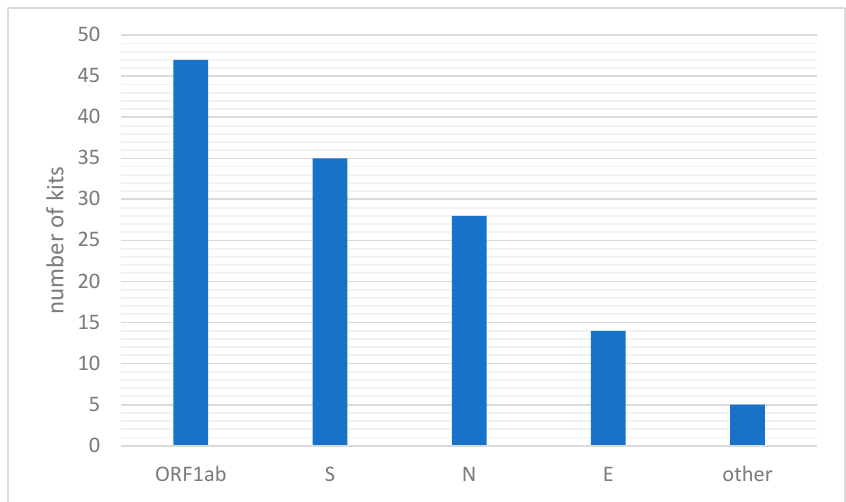
Figure 2. The number of genes detected by PCR tests for SARS-CoV-2 available in Poland.